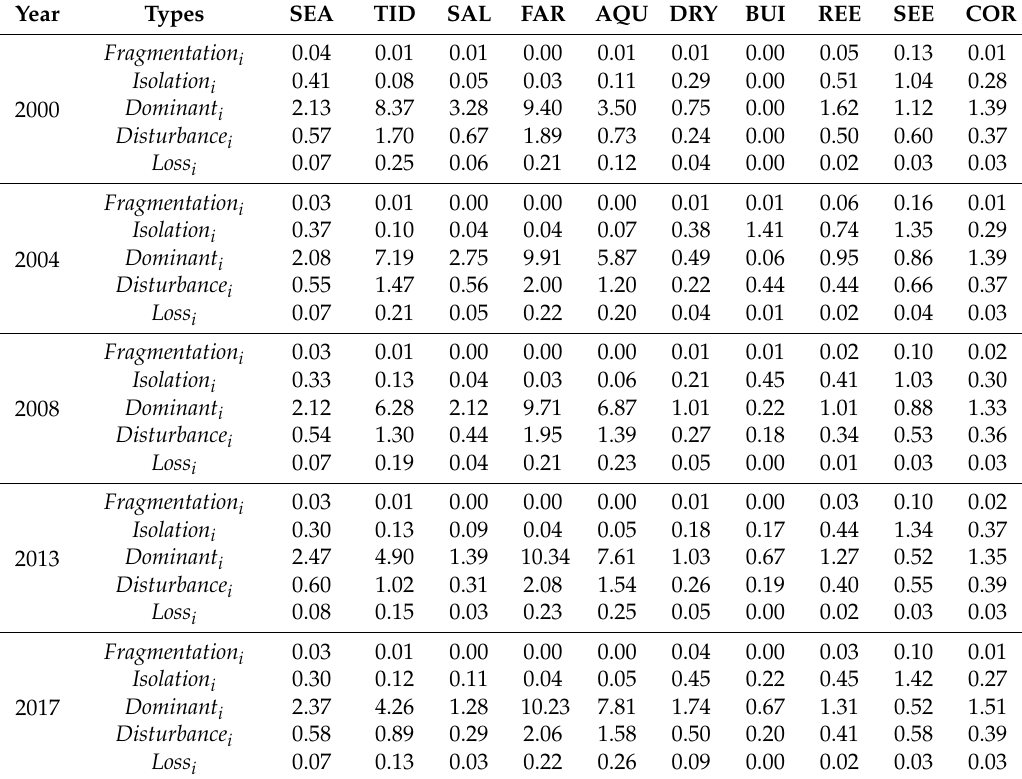
Table 3. Summary of landscape pattern indices for the study